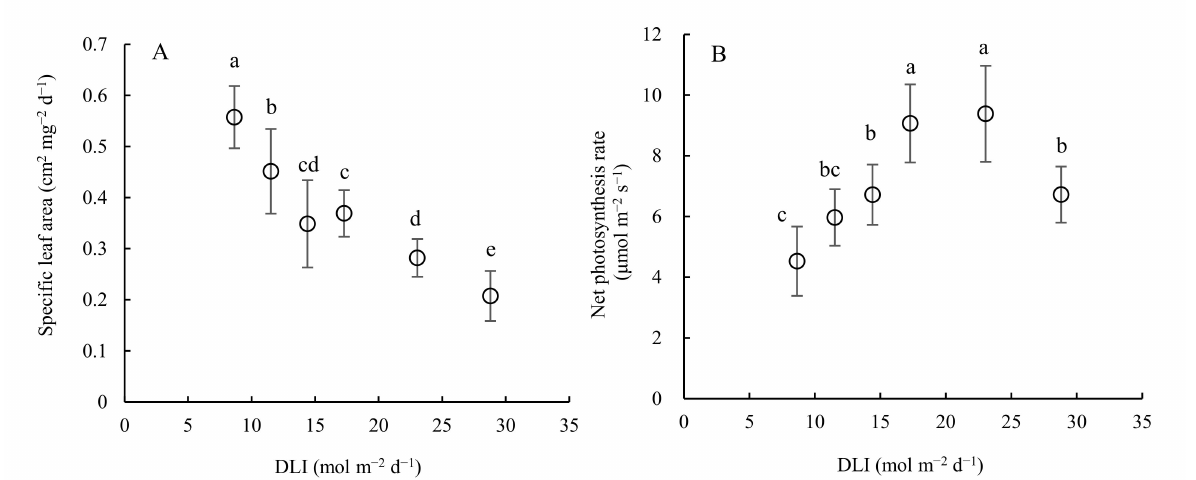
Figure 5. Relationship between daily light integral (DLI) and ( A ) specific leaf area, ( B ) net photosynthesis rate of cucumber seedlings grown for 21 days after sowing (DAS) in the closed transplant production system. Data are presented as mean ± standard deviation. Different letters indicate significant differences at p <